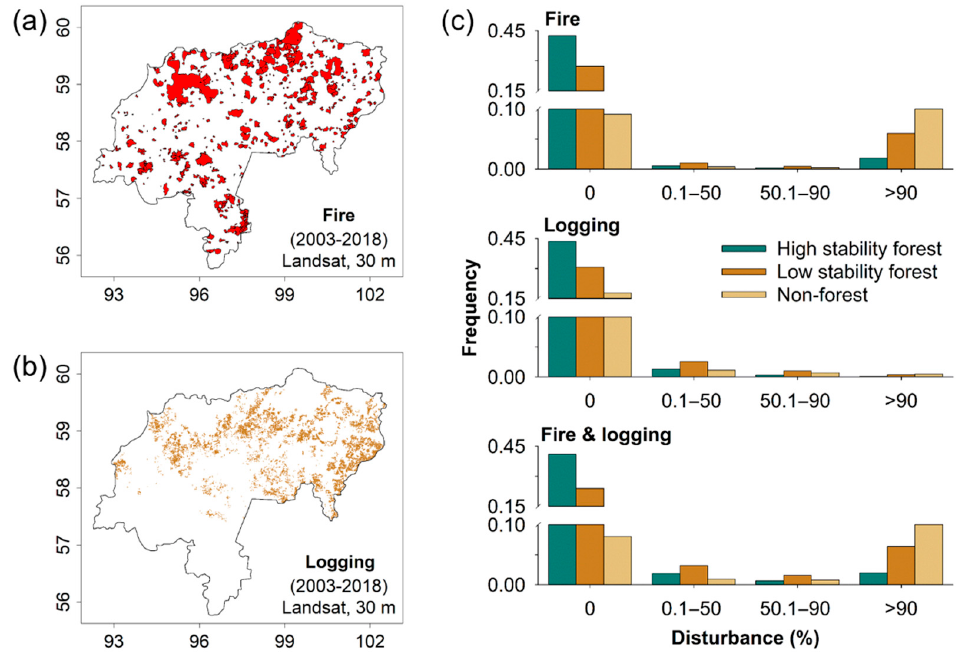
Figure 5. Spatial distribution of the major forest disturbances in Angara region (Southern Siberia, Russia) digitized from Landsat imagery over the period 2003–2018. Major disturbances considered in the validation procedure are ( a ) fire and ( b ) logging. ( c ) Frequency distribution of forest stability classes depending on the relative area of each MODIS pixel (%) affected by fire, logging, and both fire and logging (from top to bottom).